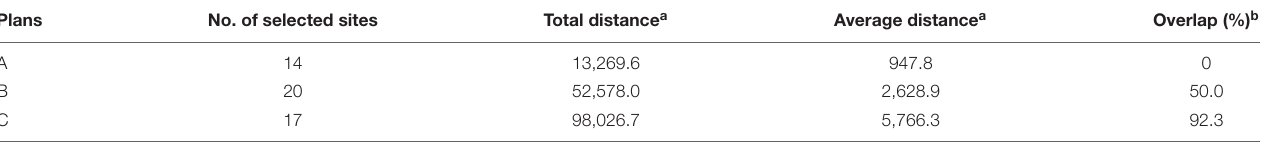
TABLE 1 | Summary of selected results for alternative conservation plans.